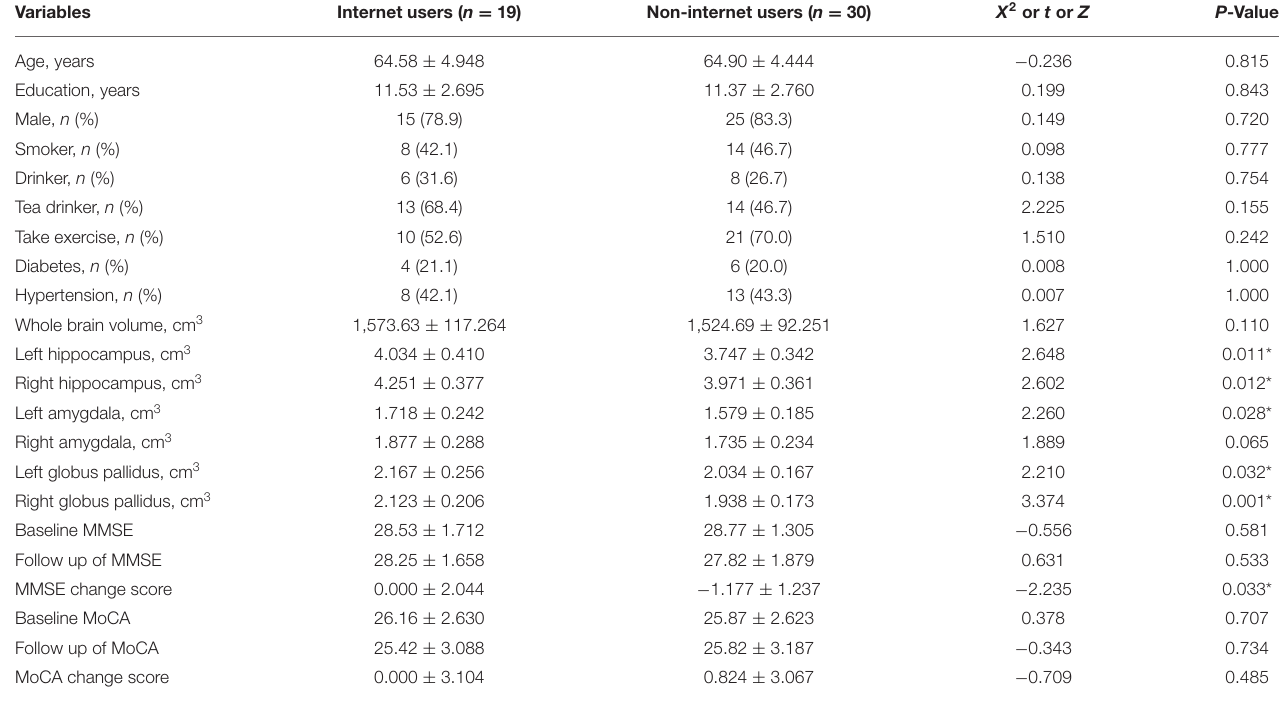
TABLE 3 | Comparison of baseline brain structure and cognitive function between internet users and non-internet users.